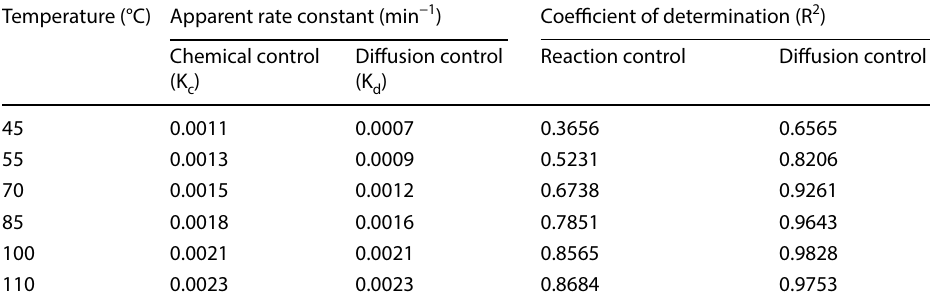
Table 3 The apparent rate constant with their coefficient of determination at different temperatures. Reproduced from Ref.